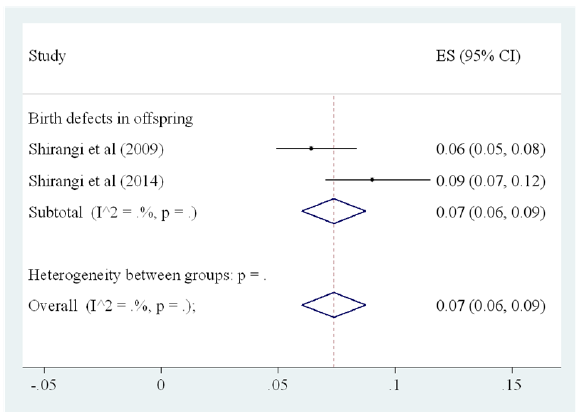
Figure 4 Forest plot of pooled prevalence of chemical hazards among veterinarians